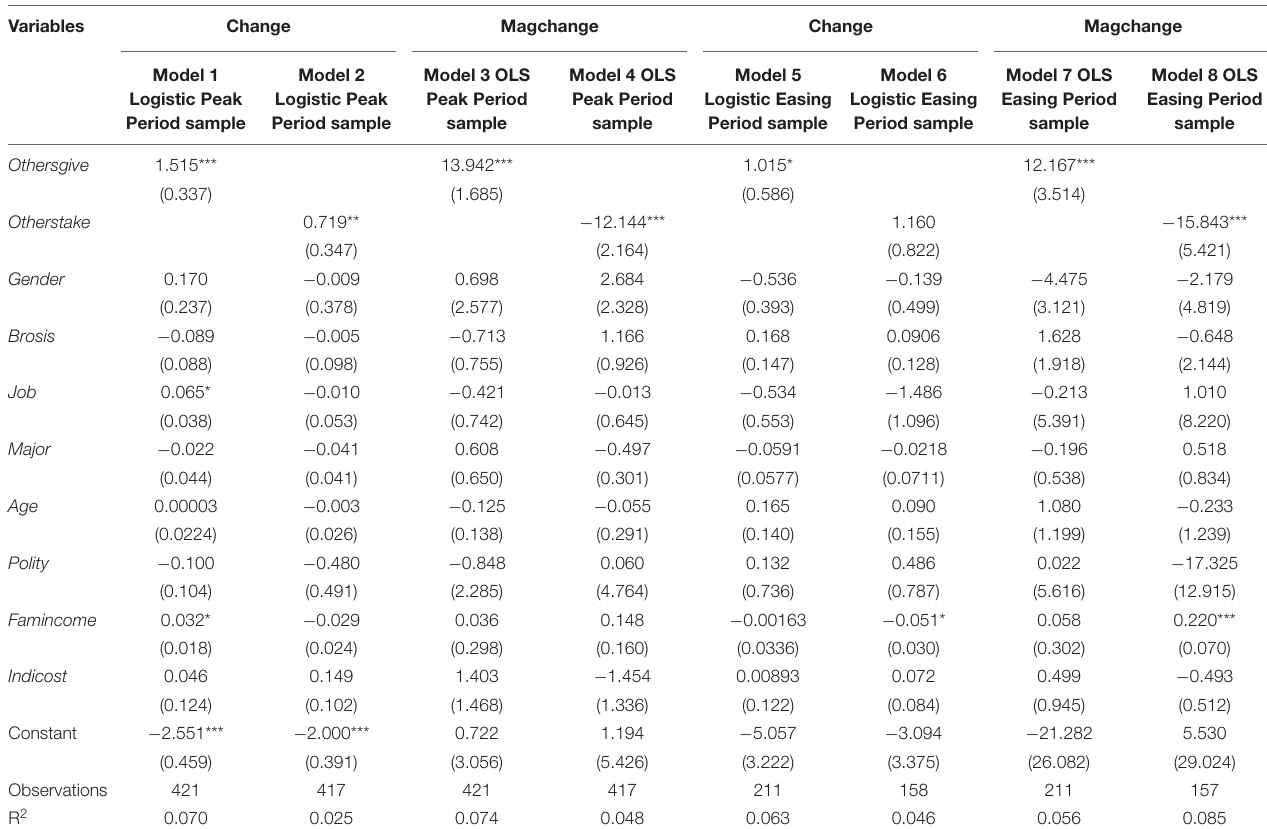
TABLE 3 | Results of regression models indicating the contagion of positive and negative donation